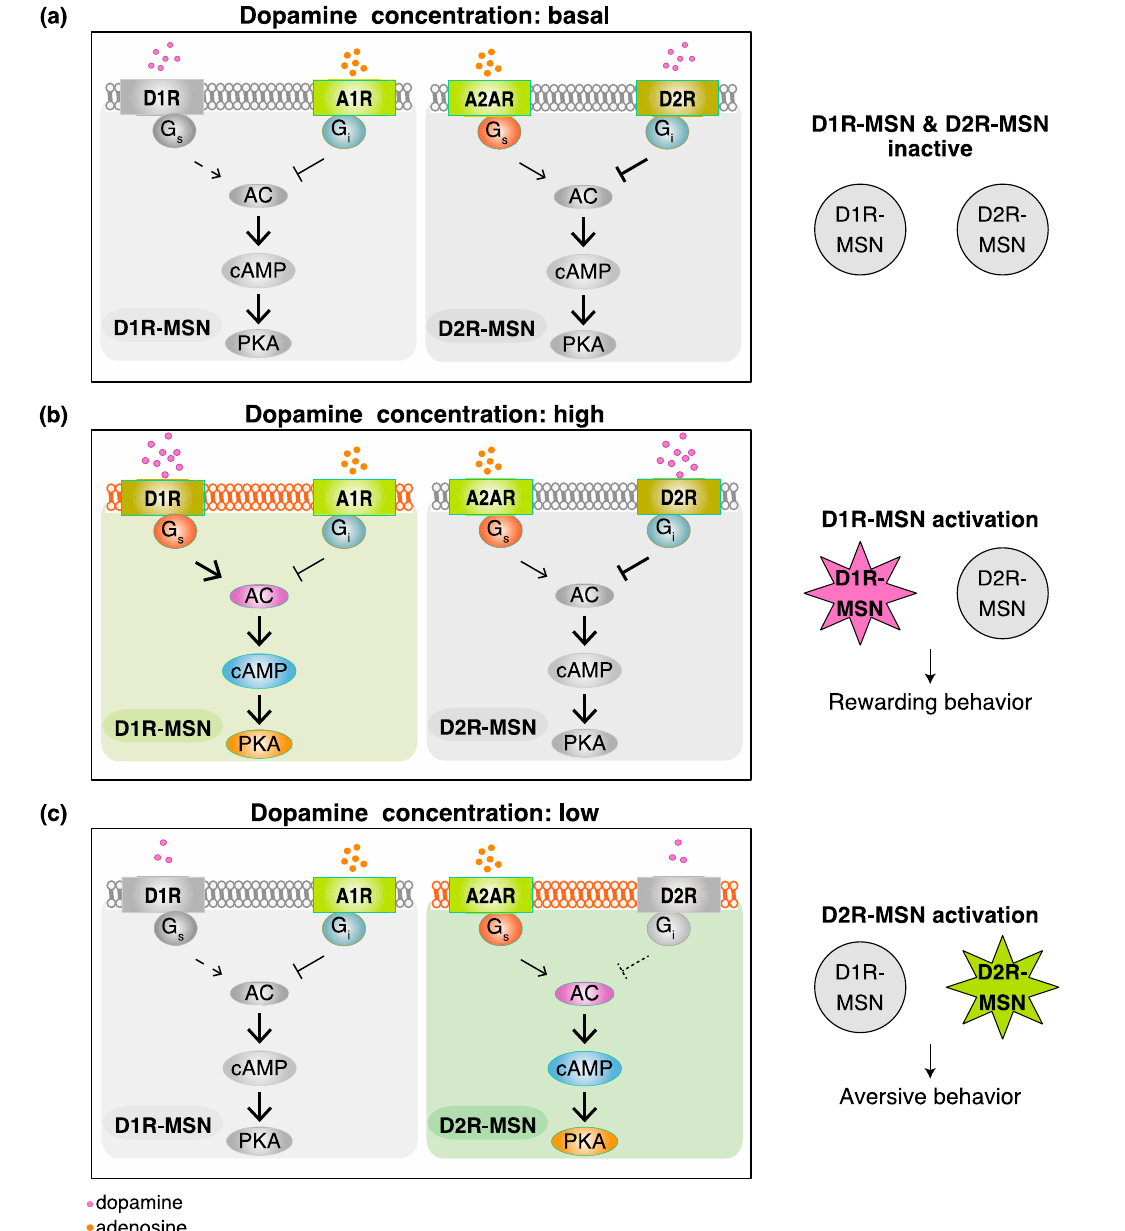
Figure 1. Dopamine concentrations function as a switch in the active state shift between D1R-MSN and D2R-MSN to regulate rewarding and aversive behaviors, respectively. ( a ) At the concentration of dopamine under basal conditions, D1R-MSN and D2R-MSN are both inactive. ( b ) When the con- centration of dopamine is high, D1R-MSN is activated, consequently leading to rewarding behavior. Under pathophysiological conditions, the dopamine hyperfunctional state may be associated with schizophrenia and drug addiction. ( c ) When the concentration of dopamine is low, D2R-MSN is activated to induce aversive behavior. Under pathophysiological conditions, the dopamine hypofunc- tional state may be associated with Parkinson’s disease, attention deficit hyperactivity disorder, and restless legs syndrome. D1R, dopamine D1 receptor; D2R, dopamine D2 receptor; A1R, adenosine A1 receptor; A2AR, adenosine A2A receptor; MSN, medium spiny neuron; Gs, stimulatory G protein; Gi, inhibitory G protein; AC, adenylate cyclase; cAMP, cyclic adenosine monophosphate; PKA, protein kinase A.